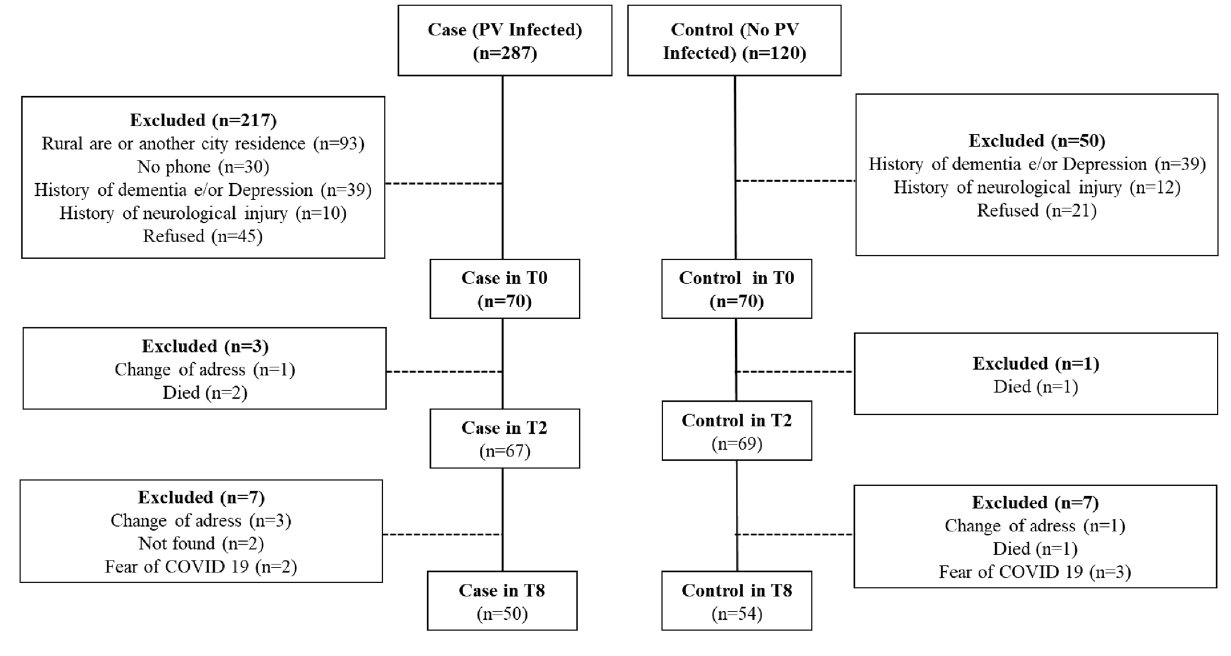
Figure 1. Flowchart of the